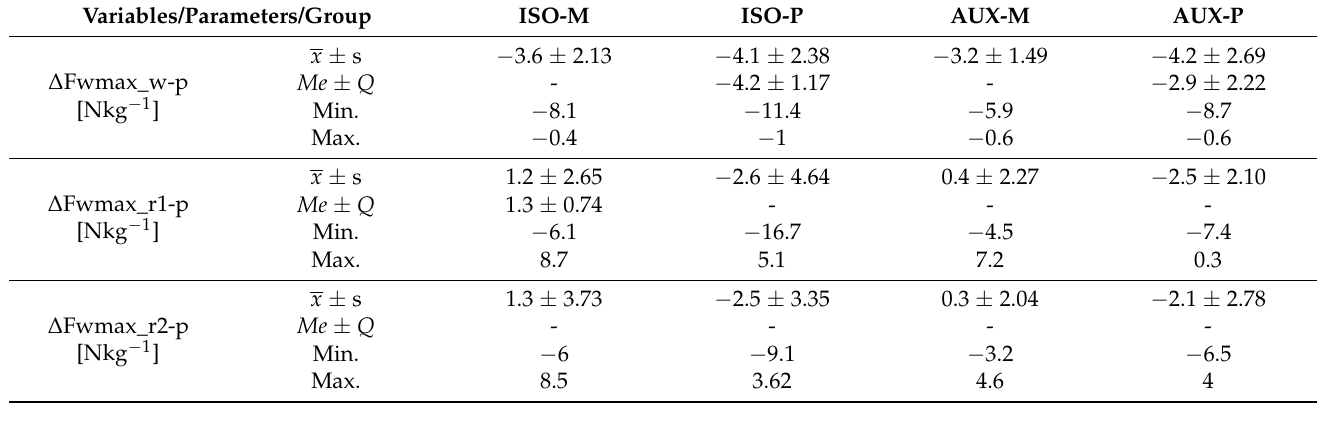
Table 2. Changes in the maximum relative strength compared to baseline expressed in Nkg − 1 , in individual stages of the experiment in groups of participants.